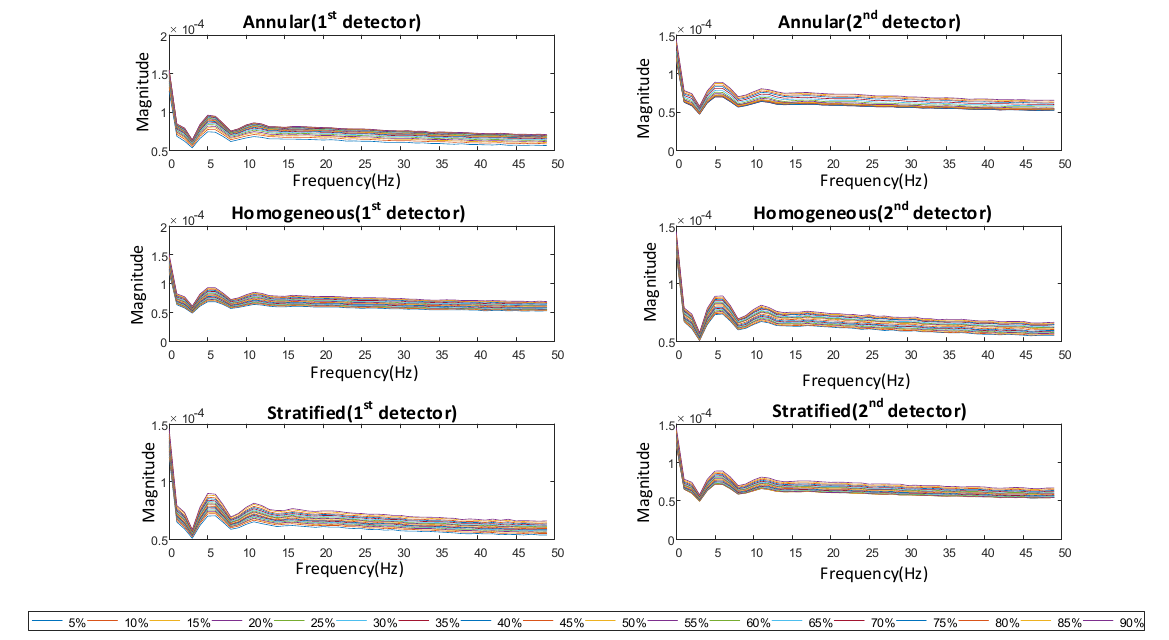
Figure 7. A comparison of fast Fourier transforms of the three flow regimes’ signals for various air percentages in the pipe.